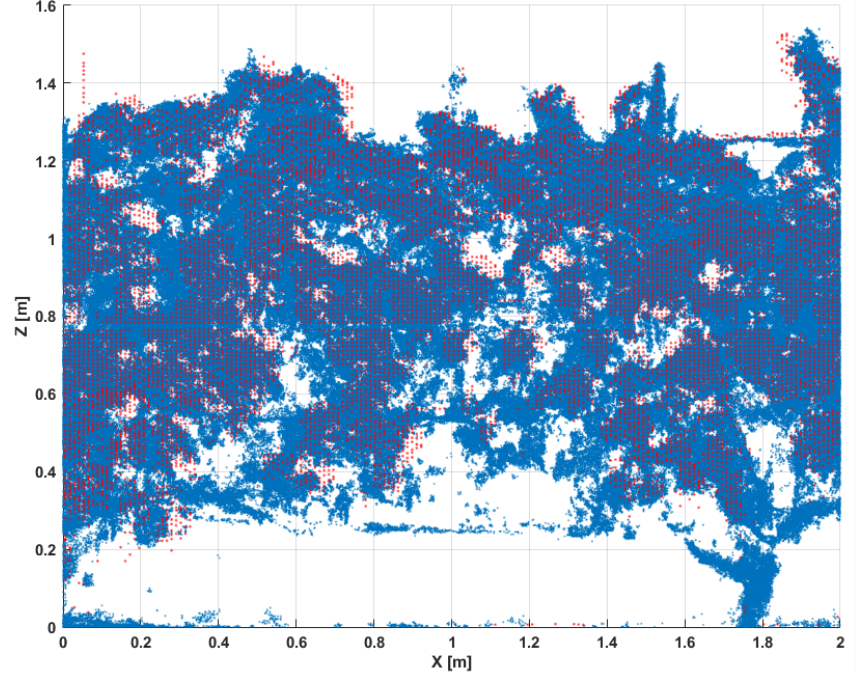
Figure 7. Comparison of point clouds from terrestrial lidar (red) and UAS photogrammetry (blue) in a side view (right side of the canopy).